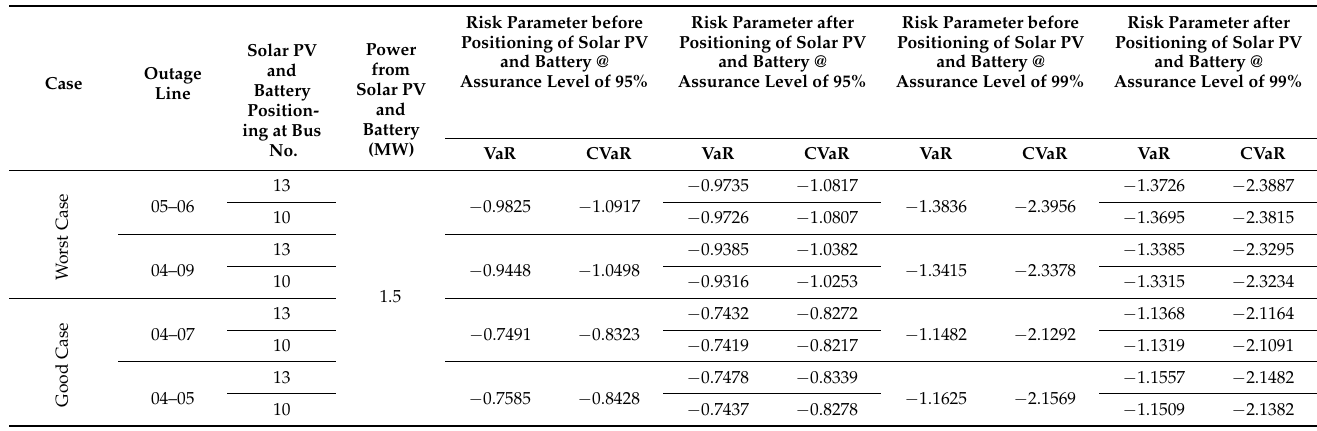
Table 9. VaR and CVaR Comparison after Installation of Solar PV and Battery with different assurance level in IEEE 14-bus System.